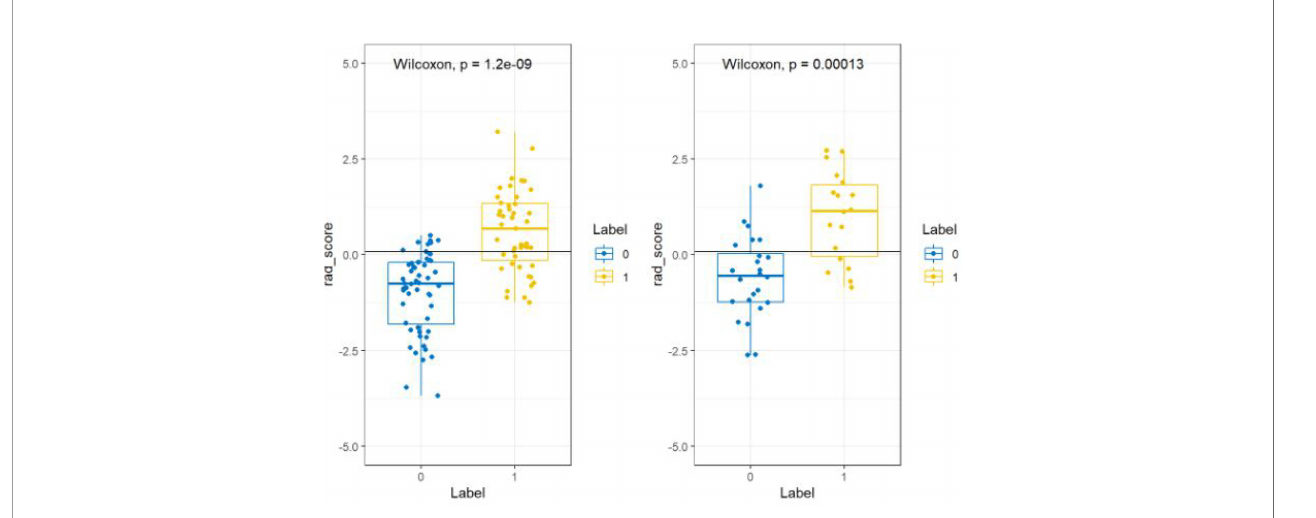
FIGURE 2 | Radiomic labels used in the group model. Comparison of imaging score between MR model training set (left) and rest set (right). The blue label is prostatic hyperplasia, and the yellow label is prostate